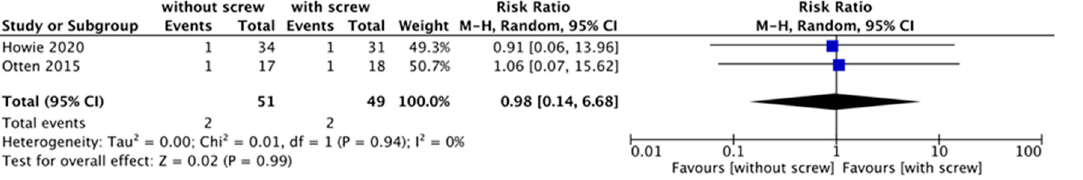
Figure 3. Forest plot of reoperation in the without and with screw fixation groups [10,14]. (M-H: